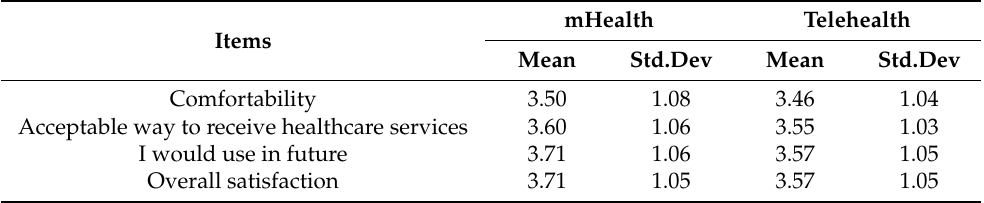
Table 12. Satisfaction and future use of mHealth and